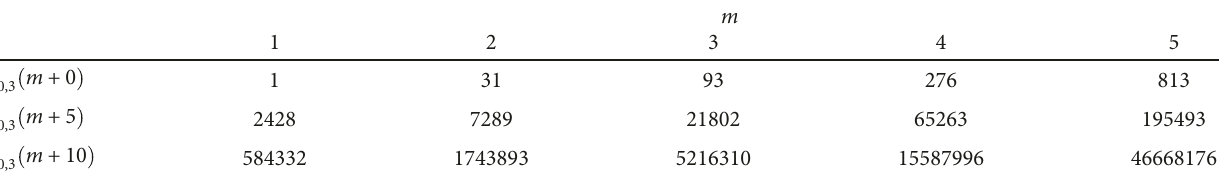
n sequence for n ≤ 15 . 10,3